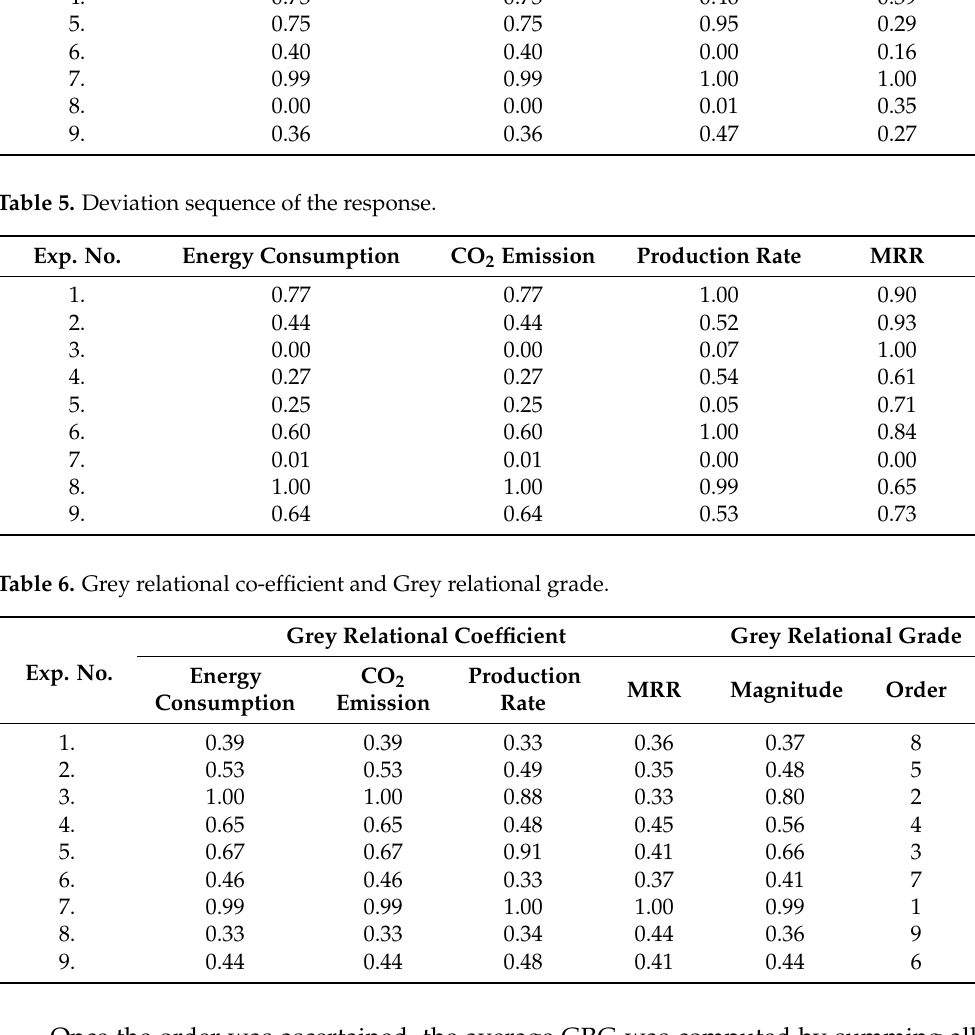
Table 4. Normalizing sequence of the responses.